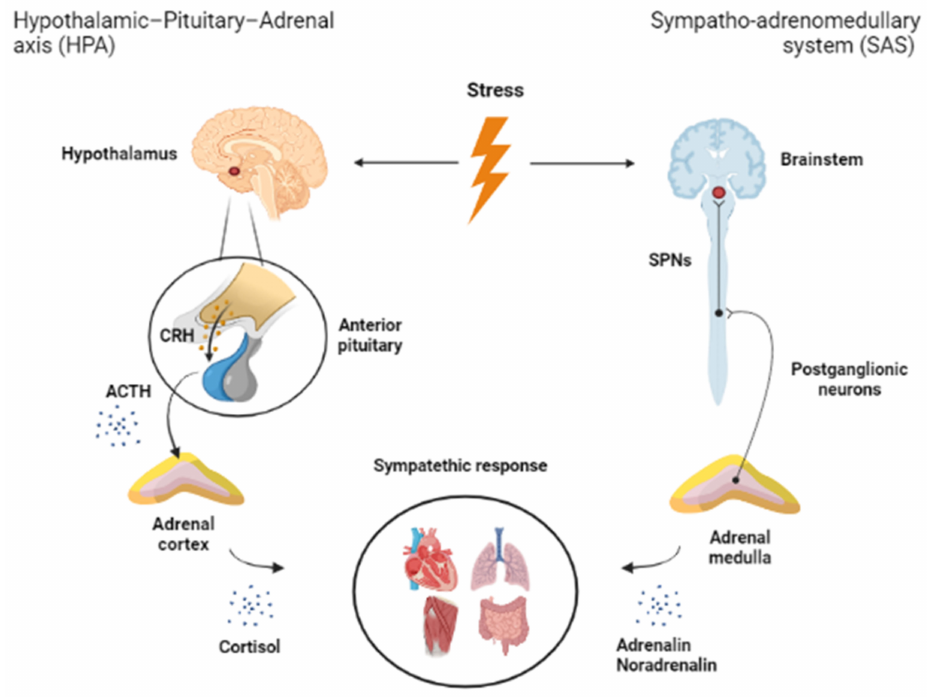
Figure 1. Main regulatory pathways of stress adaptation. There are two major limbs of stress adaptation: (1) the hypothalamic–pituitary–adrenocortical axis originating from the paraventricular nucleus of the hypothalamus, as well as (2) the sympatho–adrenomedullary system originating in the brainstem. Abbreviations: ACTH: adrenocorticotropin hormone, CRH: corticotropin-releasing hormone, SPN: sympathetic preganglionic neurons. This figure was created in